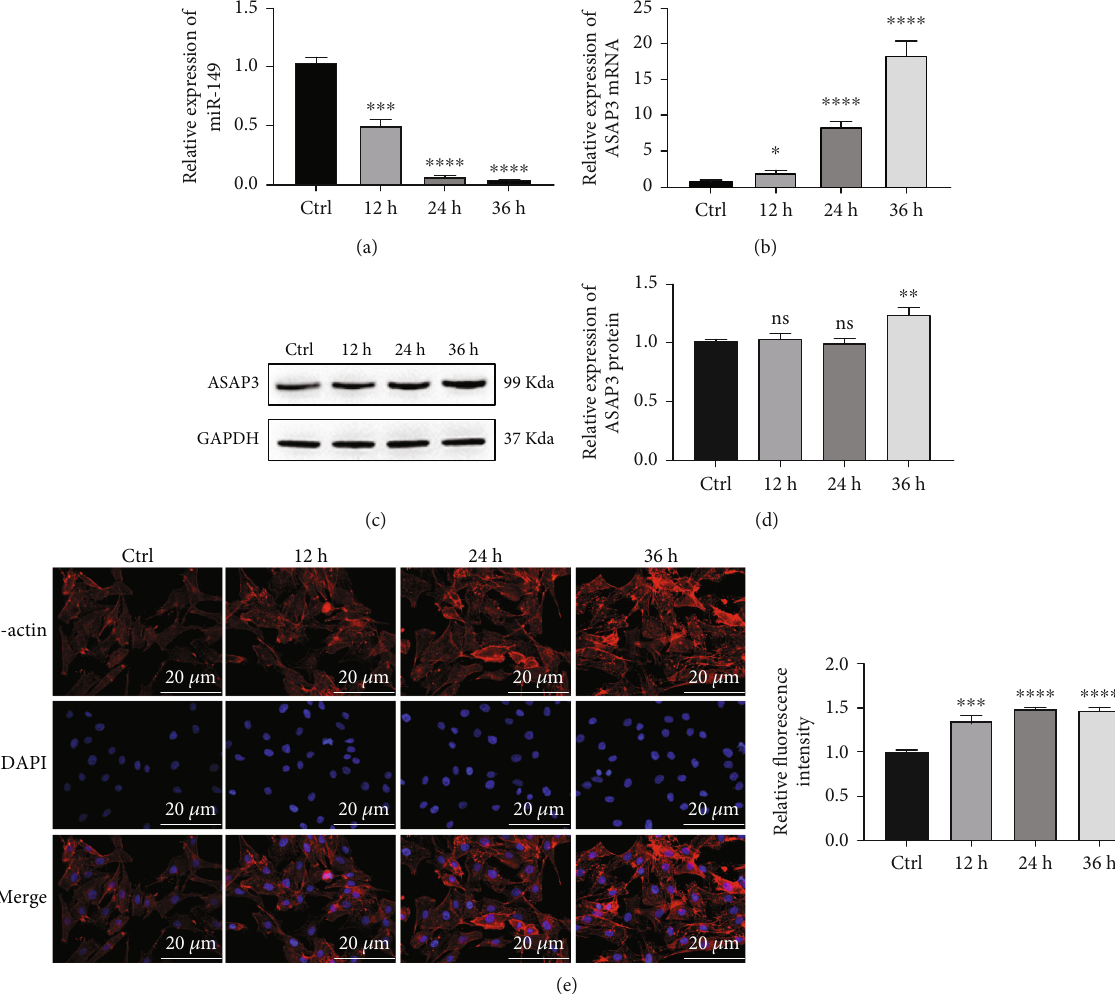
Figure 3: The expression of miR-149 and ASAP3 in MG63 under mechanical tension. RT-qPCR detected the expression of miR-149 (a) and ASAP3 mRNA (b). (c, d) Western blot was used to detect the protein of ASAP3. (e) F-actin fl uorescence intensity was detected by rhodamine-labeled phalloidin staining. Compared with the ctrl group, ∗ P < 0 : 05 , ∗∗ P < 0 : 01 , ∗∗∗ P < 0 : 001 , and ∗∗∗∗ P < 0 : 0001 ; ns: no signi fi cant di ff